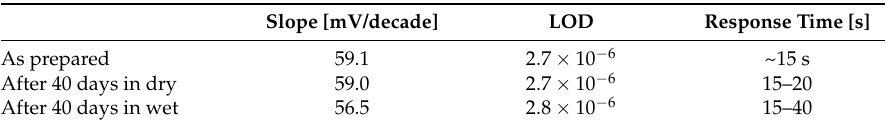
Figure 7. Calibration traces obtained from the freshly prepared Li + SC-ISE (green) and the ones after 40 days of storage in dry (light blue) and then in wet (dark blue) conditions. Platinum nanoflowers were deposited by LSV2. LiCl solution was added every 50 s to achieve a half-log increase of the concentration. Table 3. Sensor parameters obtained from the calibration traces in Figure 7 for the freshly prepared Li + SC-ISE and the ones after 40 days of storage in dry and then in wet conditions. (Calibration range between 10 − 7 M and 10 − 1